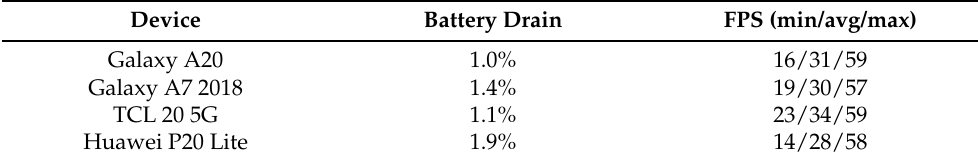
Table 4. Average results of 10 tests of 10 sort quest